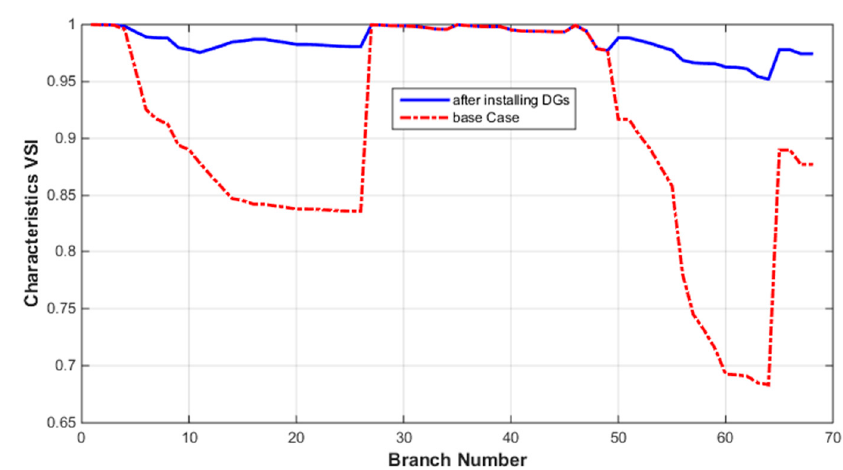
Figure 22. Characteristics of VSI, three DGs at unity pf.